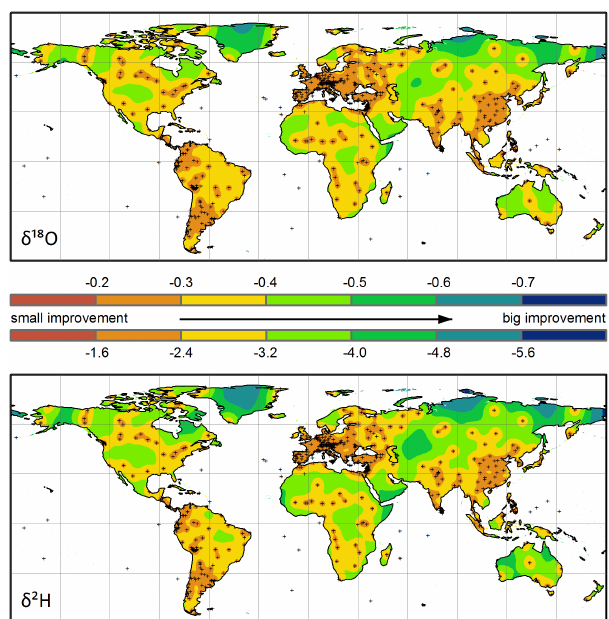
Fig. 10. A global map of the difference in prediction uncertainty between Models M1 and M4 ( ∆ σ = σ M4 − σ M1 ) for δ 18 O ANN (upper map, scale) and δ 2 H ANN (lower map, scale), expressed in ‰. Stations are indicated with “+”